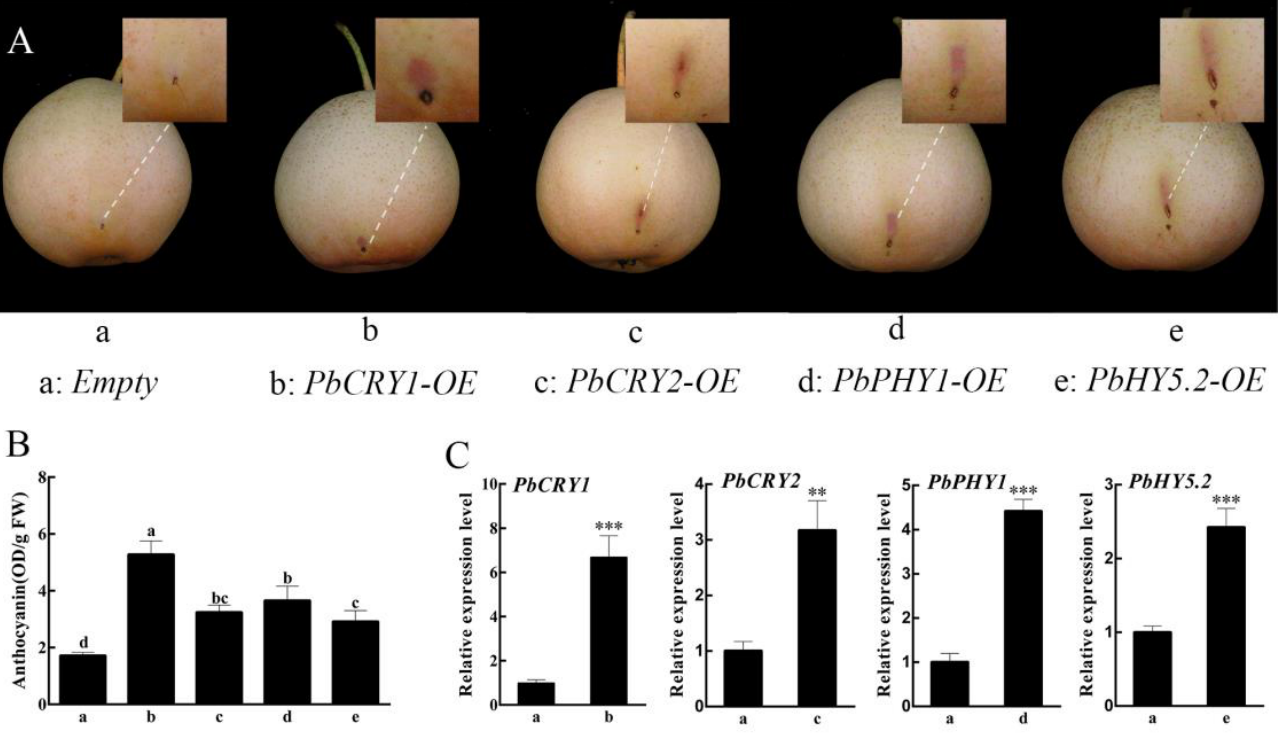
Figure 5. Transient overexpression of PbCRY1, PbPHY1, PbHY5.2, and PbCRY2 in the skin of pear fruit: ( A ) PbCRY1, PbPHY1, PbHY5.2, and PbCRY2 overexpression in ‘ Qindaohong ’ pear. ( B ) An- thocyanin content in the skin; FW: fresh weight. ( C ) Relative expression levels of PbCRY1 , PbPHY1 , PbHY5.2 , and PbCRY2 detected by qRT-PCR analysis. Data are the mean ± S.E. of three replicates. Different letters above the bars indicate significant differences (Duncan’s multiple range test p < 0.05). Asterisks above the bars indicate significant differences in expression level (Student’s t -test: ** p < 0.01, *** p < 0.001).